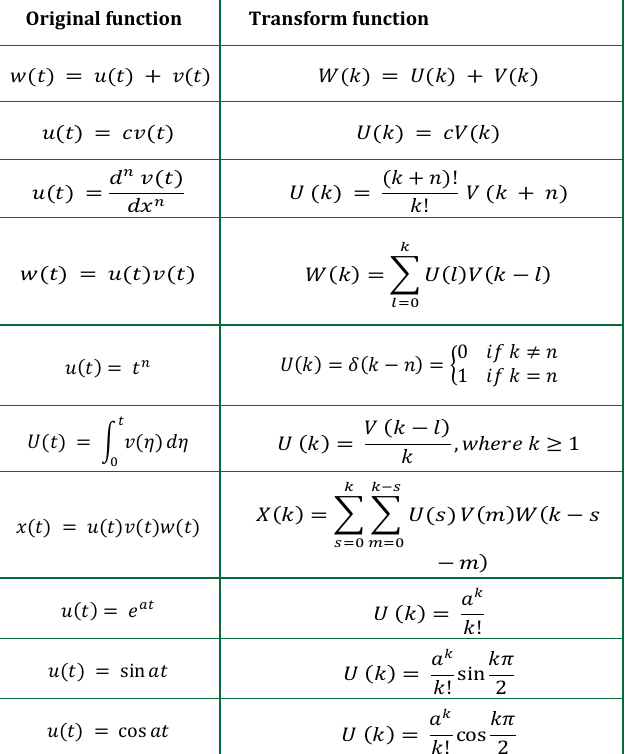
Table 1: Various time dimensional differential transformations.